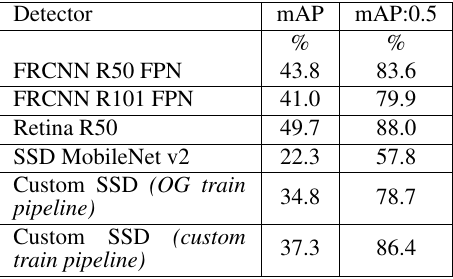
Table 3. Overall detection results (after hyperparameter tuning) for the TomatOD dataset.